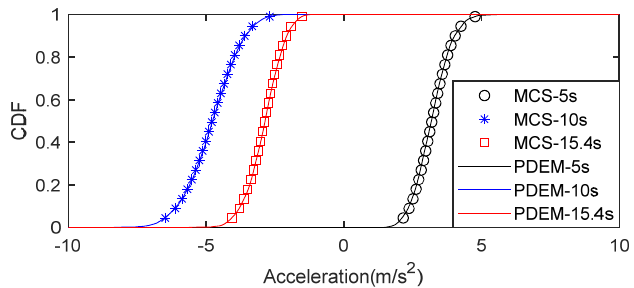
Figure 11. Comparison of CDF of structural mid—span acceleration.